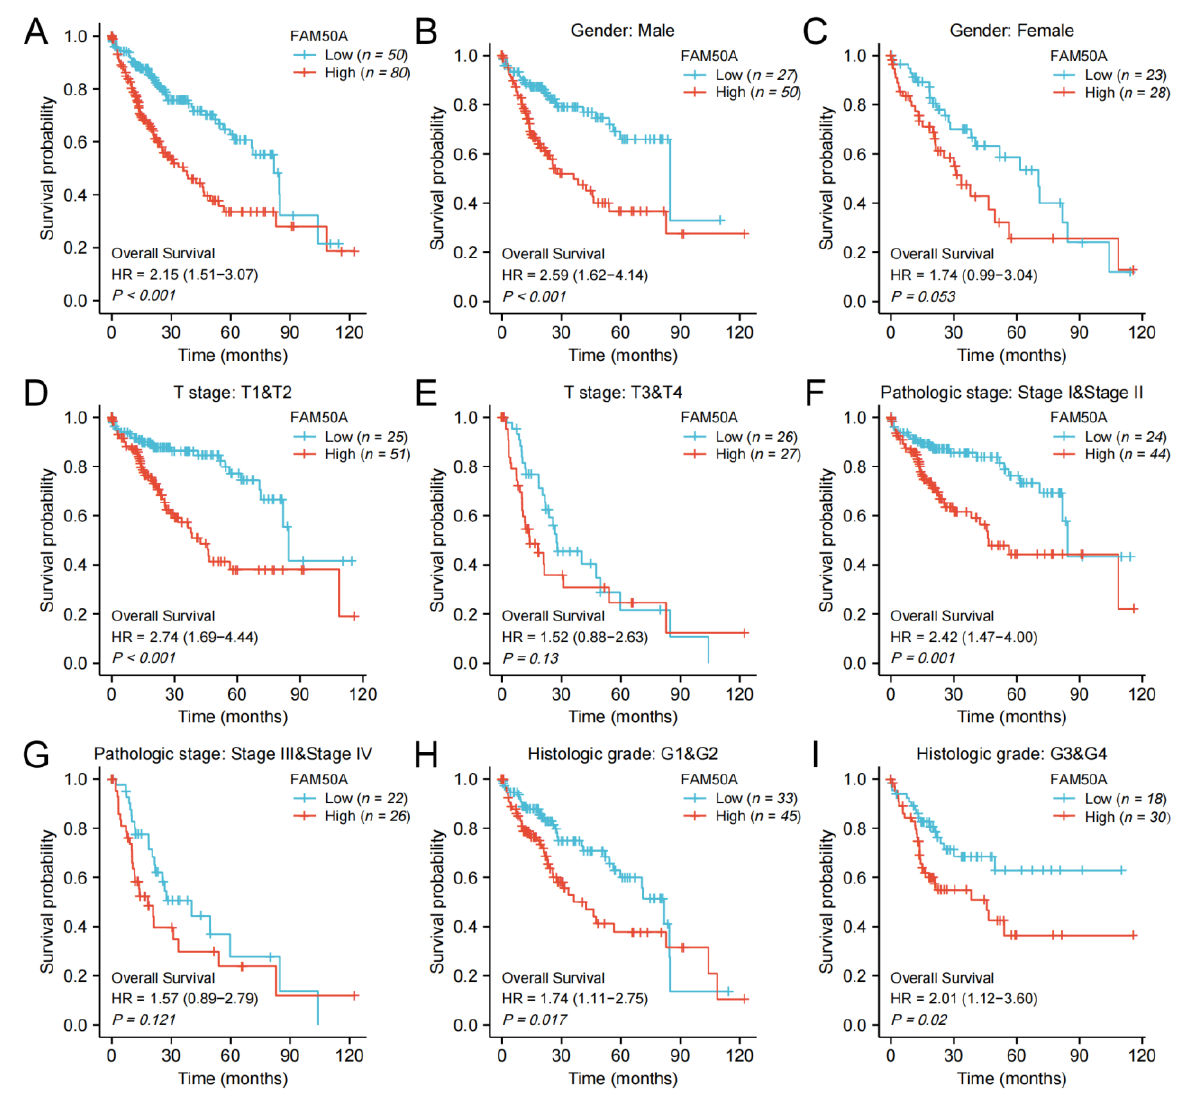
Figure 2. Kaplan–Meier survival analysis. We analyzed the effects of FAM50A on OS in HCC patients with the help of information from TCGA. ( A ) All HCC patients. ( B ) Male patients. ( C ) Female patients. ( D ) T stage (T1 and T2). ( E ) T stage (T3 and T4). ( F ) Pathologic stage I and II. ( G ) Pathologic stage III and IV. ( H ) Histologic grade 1 and 2. ( I ) Histologic grade 3 and 4.